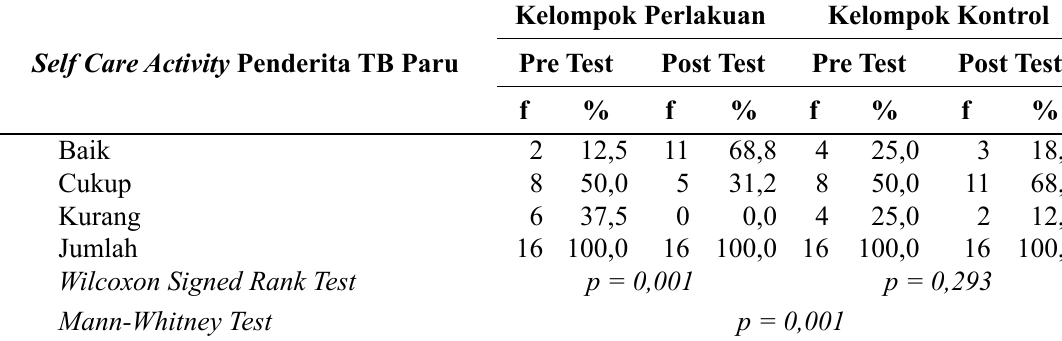
Self Care Activity Penderita TB